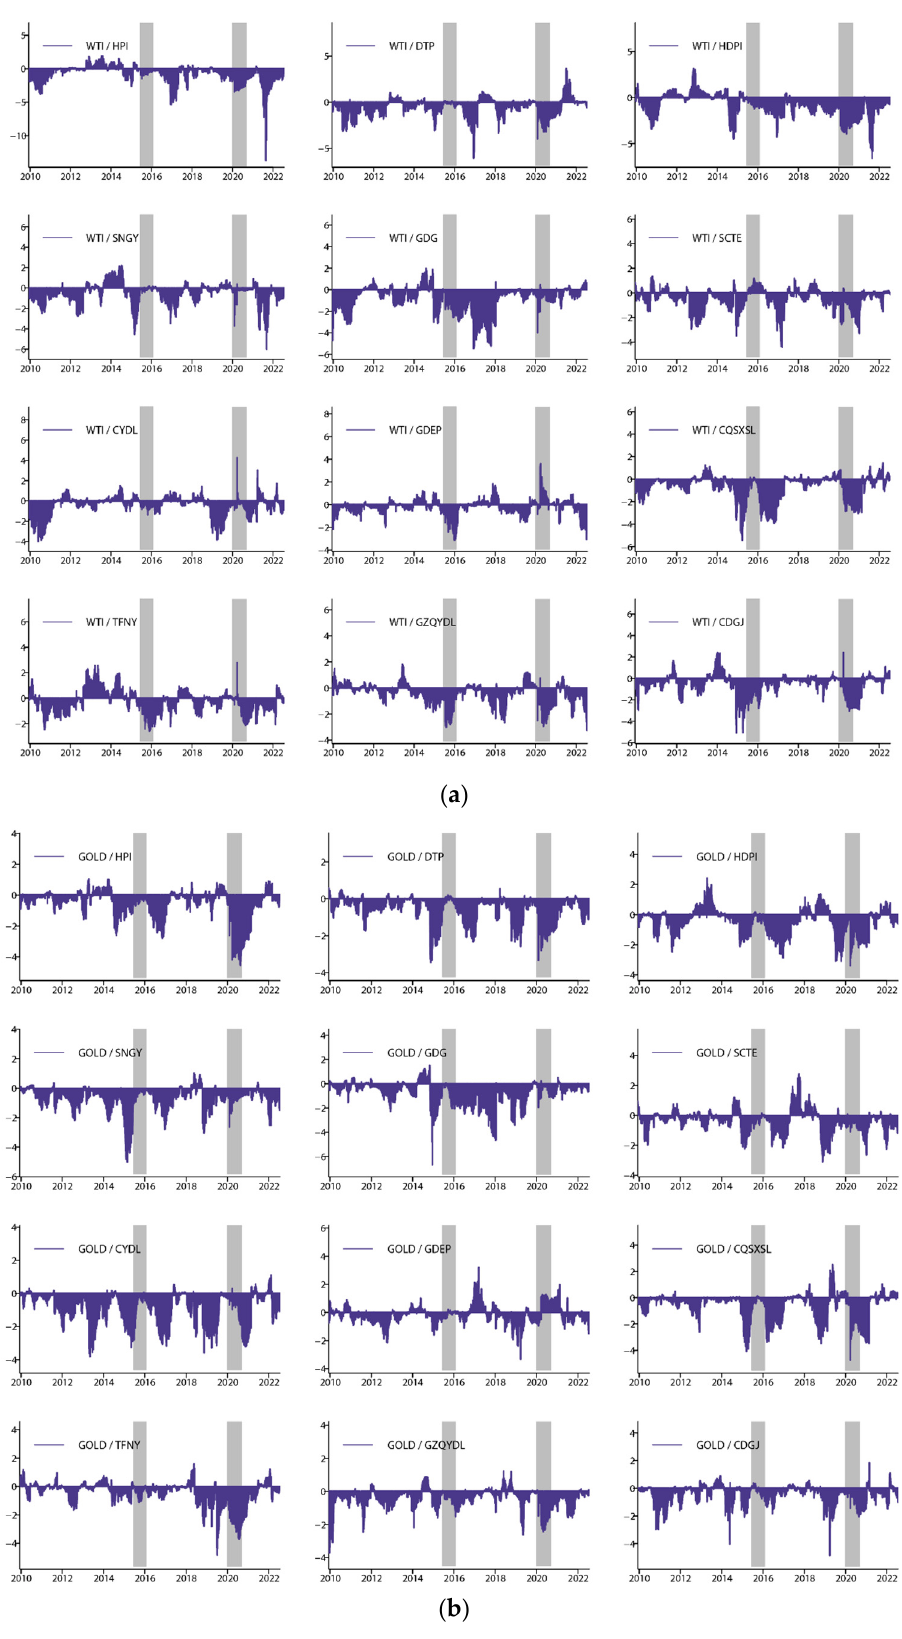
Figure 3. ( a ) Net dynamic pairwise volatility directional spillover between WTI and electricity companies’ stock prices; ( b ) Net dynamic pairwise volatility directional spillover between gold and electricity companies’ stock prices.